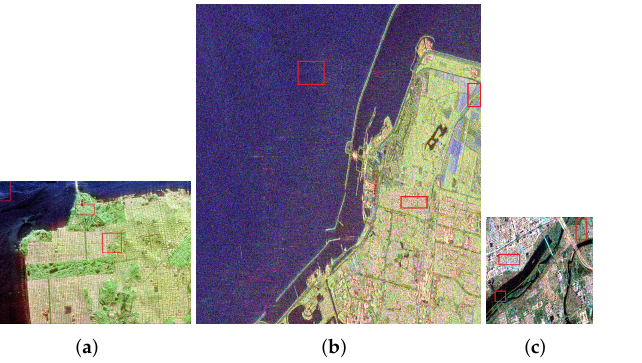
Figure 8. Big blocks in multi-PolSAR images, which are marked by red boxes and each only contains one land cover in every PolSAR image. ( a ) Big blocks in San Francisco. ( b ) Big blocks in Flevoland. ( c ) Big blocks in Xi’an.